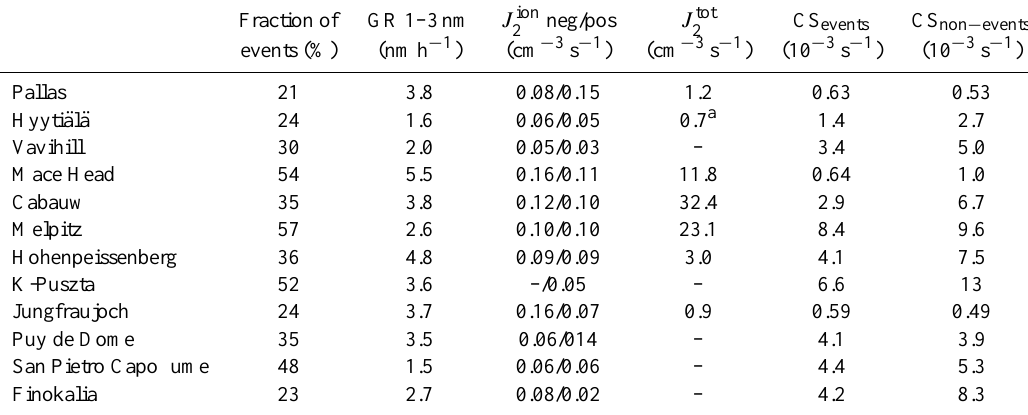
Table 3. Summary of the median particle formation event characteristics on the twelve EUCAARI sites. First the fraction of event days of all available days for analysis, GR is the growth rate in 1.5–3nm size range, J ion total particle formation rate during an event. CS events is the condensation sink during the events and CS non − events is the condensation sink for the non-event days.